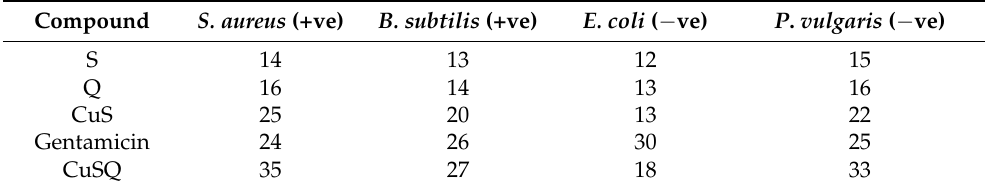
Table 4. Antibacterial bioassay of Salen ligand and its CuSQ complex against different strains of bacteria. Figure 3. Antibacterial activity (inhibition zone) of Salen, CuS, S, Q, and CuSQ compared to gen ‐ tamicin at concentration of 10 mg mL –1 .